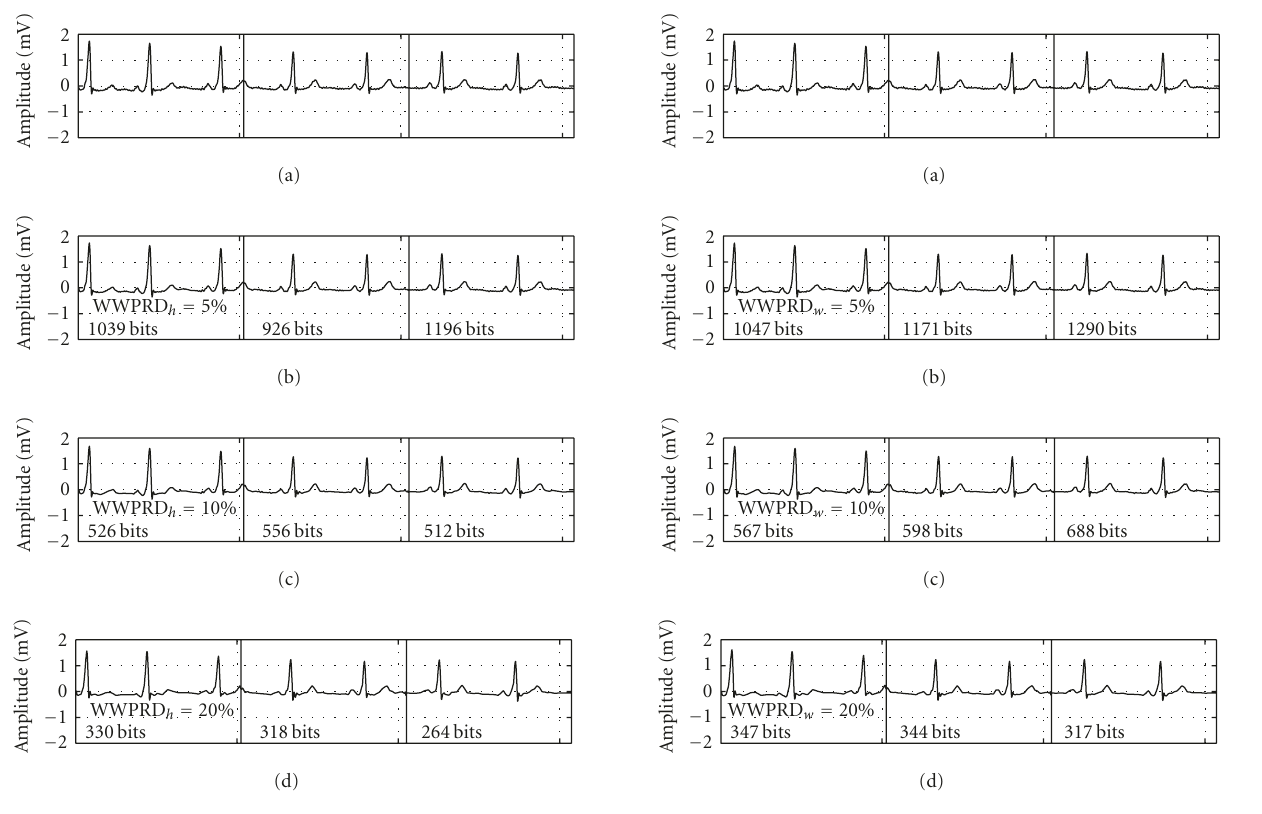
Figure 5: (a) Original signal. (b) Reconstructed signal when guar- anteeing WWPRD h = 5%. (c) Reconstructed signal when guaran- teeing WWPRD h = 10%. (d) Reconstructed signal when guaran- teeing WWPRD h = 20%.